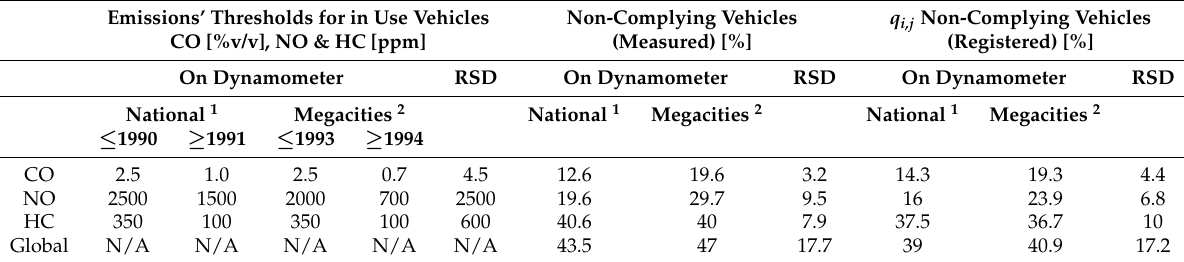
Table 3. Emissions’ thresholds from local regulations for in-use vehicles along with the estimated percentage of non-complying vehicles in MMA, according to the 2018 RDS monitoring